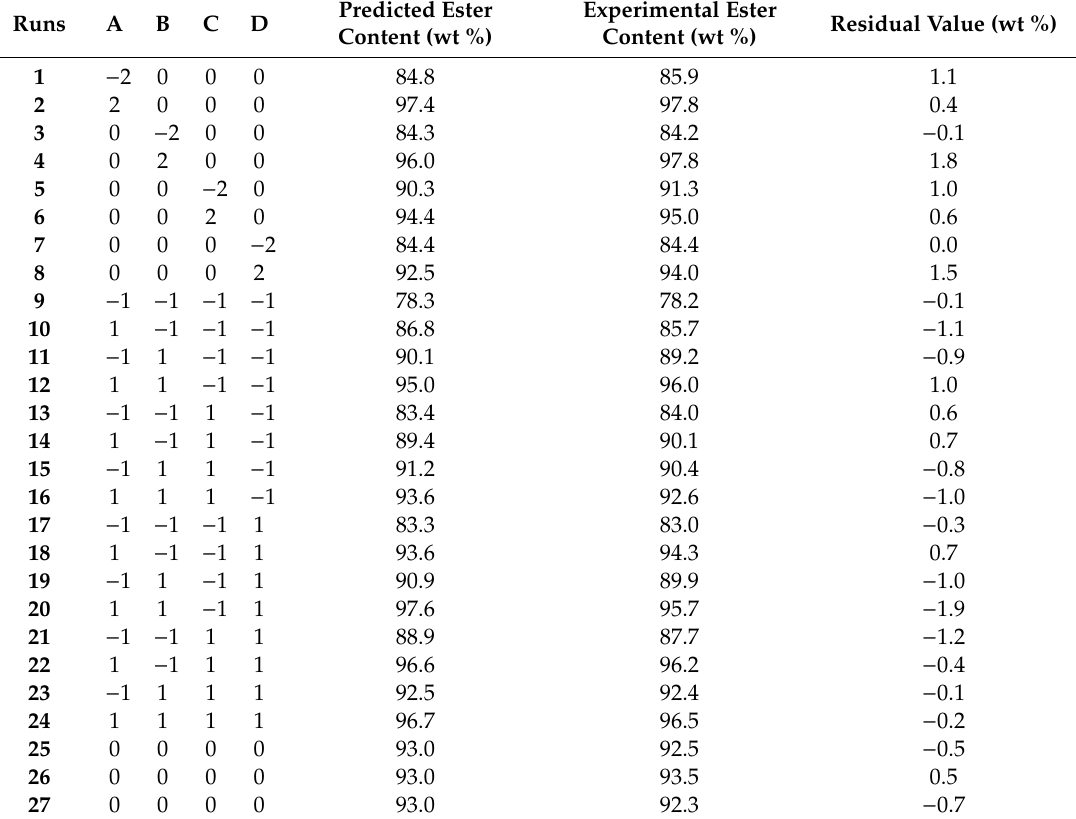
Table 11. CCD, predicted and experimental ester content, and residual values of the design.